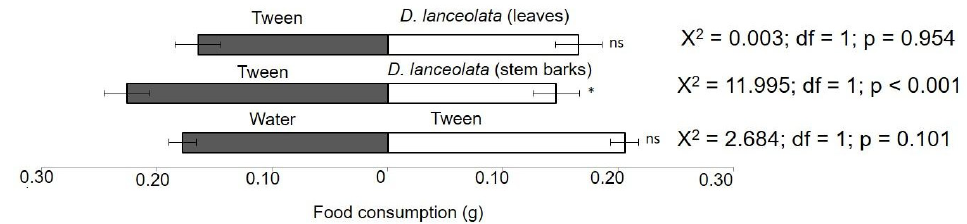
Figure 6. Food consumption (g) of Spodoptera frugiperda caterpillars exposed to diets treated with essential oils from the leaves and bark of the Duguetia lanceolata in food preference assay. The same letters do not differ statistically by Χ 2 test.